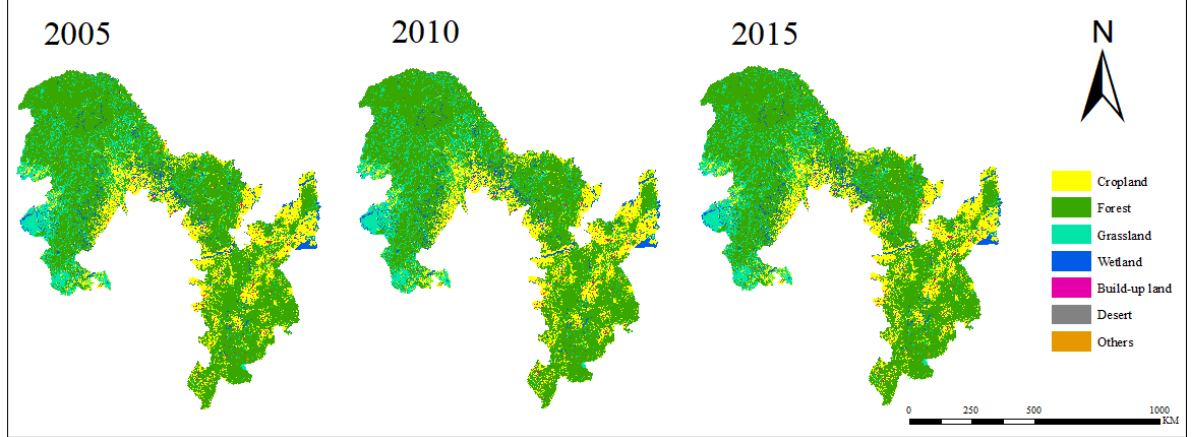
Figure 3. Spatial distribution of different land use types in the Northeast Forest Belt (NFB) from 2005 – 2015. Table 4. Statistics of different land use types of ecosystem patterns of the NFB from 2005 – 2015.